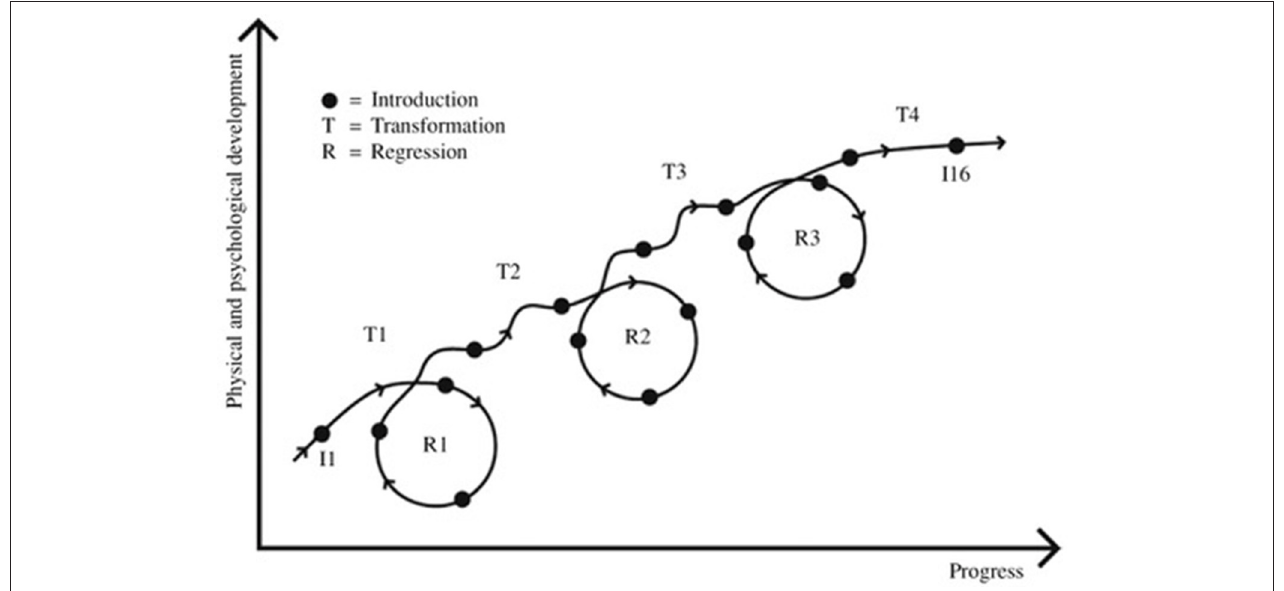
FIGURE 1 | The participants needed close to 16 visits on average in order to complete the treatment in accordance with the sensorimotor therapy program Retraining of Balance. The visits (the introductions) are distributed along the curve above (I1–I16) and indicated as dots, During the treatment period three regression periods, here illustrated as circles (R1–R3), and four periods of transformation (T1–T4) were identified. (Reprinted from Social Behavior personality by kind permission. Originally Published 2010, 38(3),